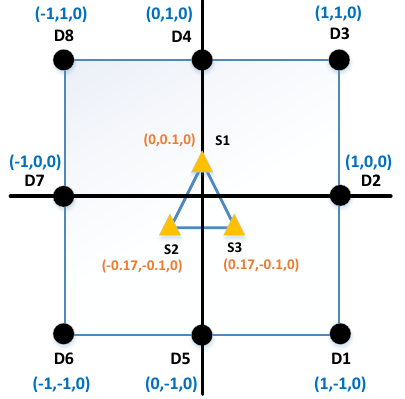
Figure 11. Placement of multiple release sources in a triangular arrangement (distance in